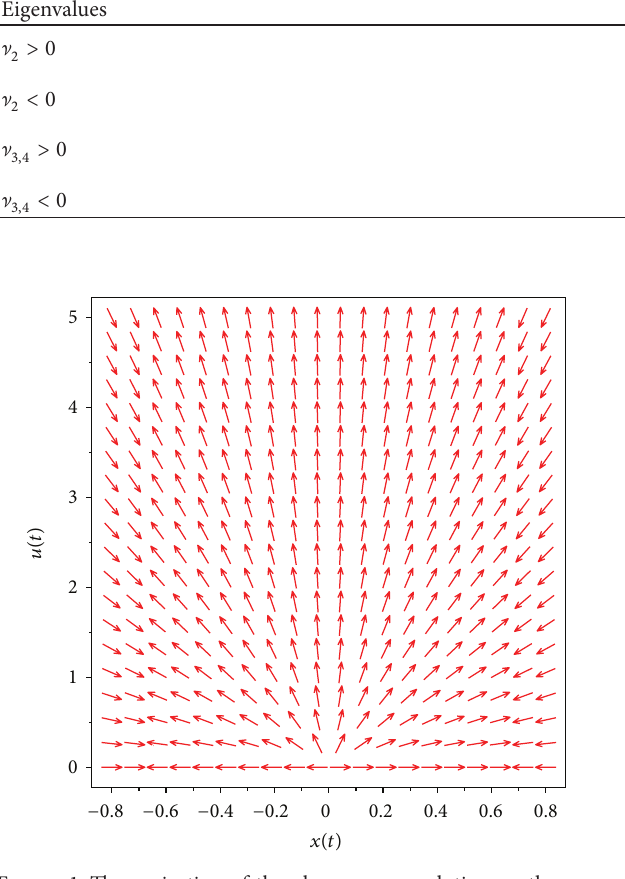
nonvanishing eigenvalues of the perturbation matrix are negative, the critical line L 1 can be a stable attractor.